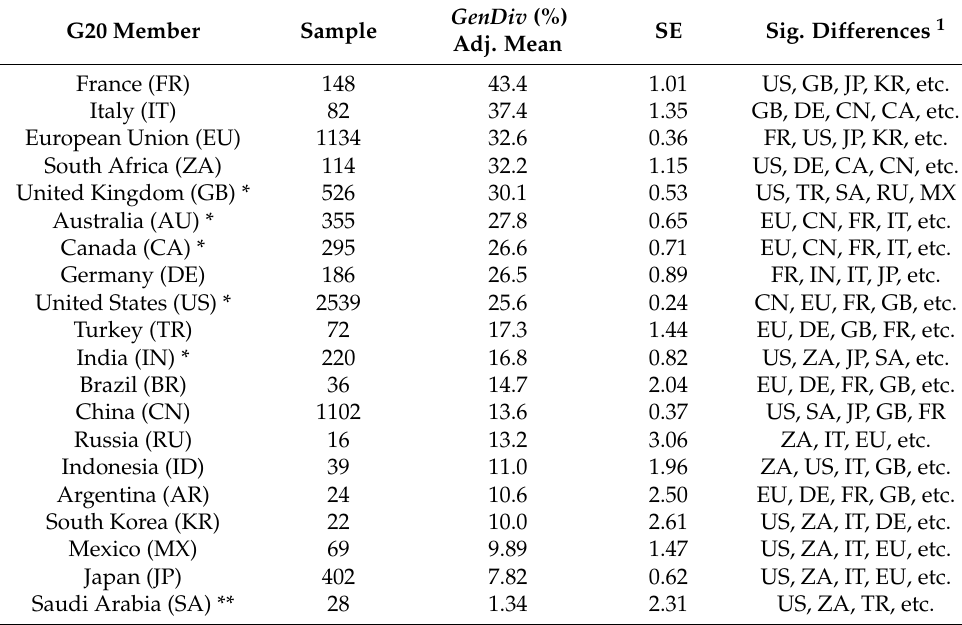
Table 6. The analysis of covariance of GenDiv by country/group of countries, adjusted for company size, in descending order. G20 Member Sample